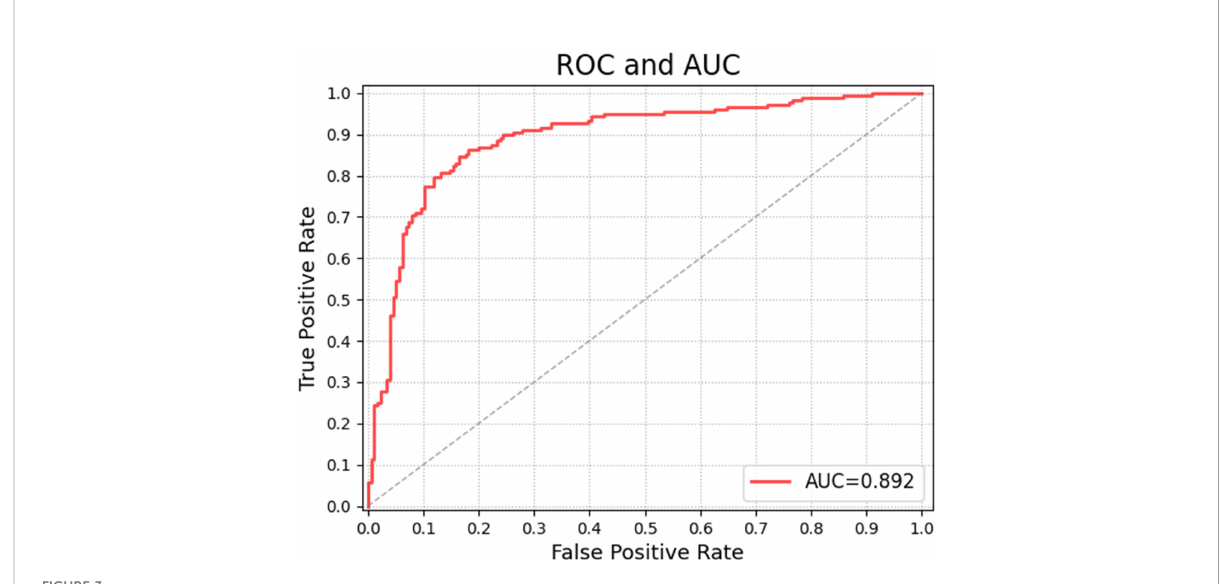
FIGURE 3 ROC curve of the proposed model on balanced data set.